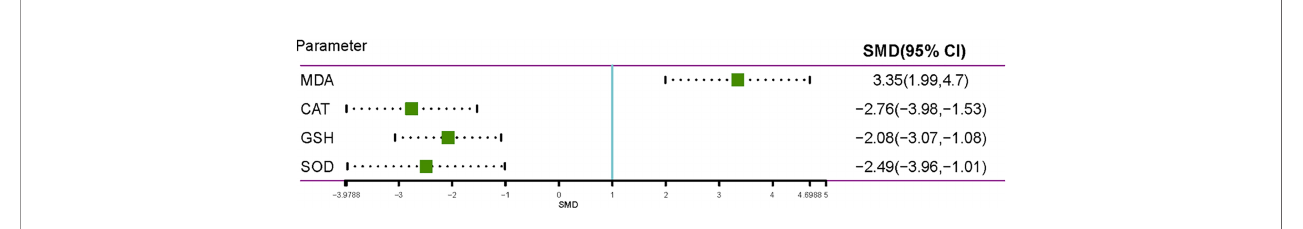
FIGURE 5 | Forest plot showing the effect of pyrethroid oxidative stress induction on rats